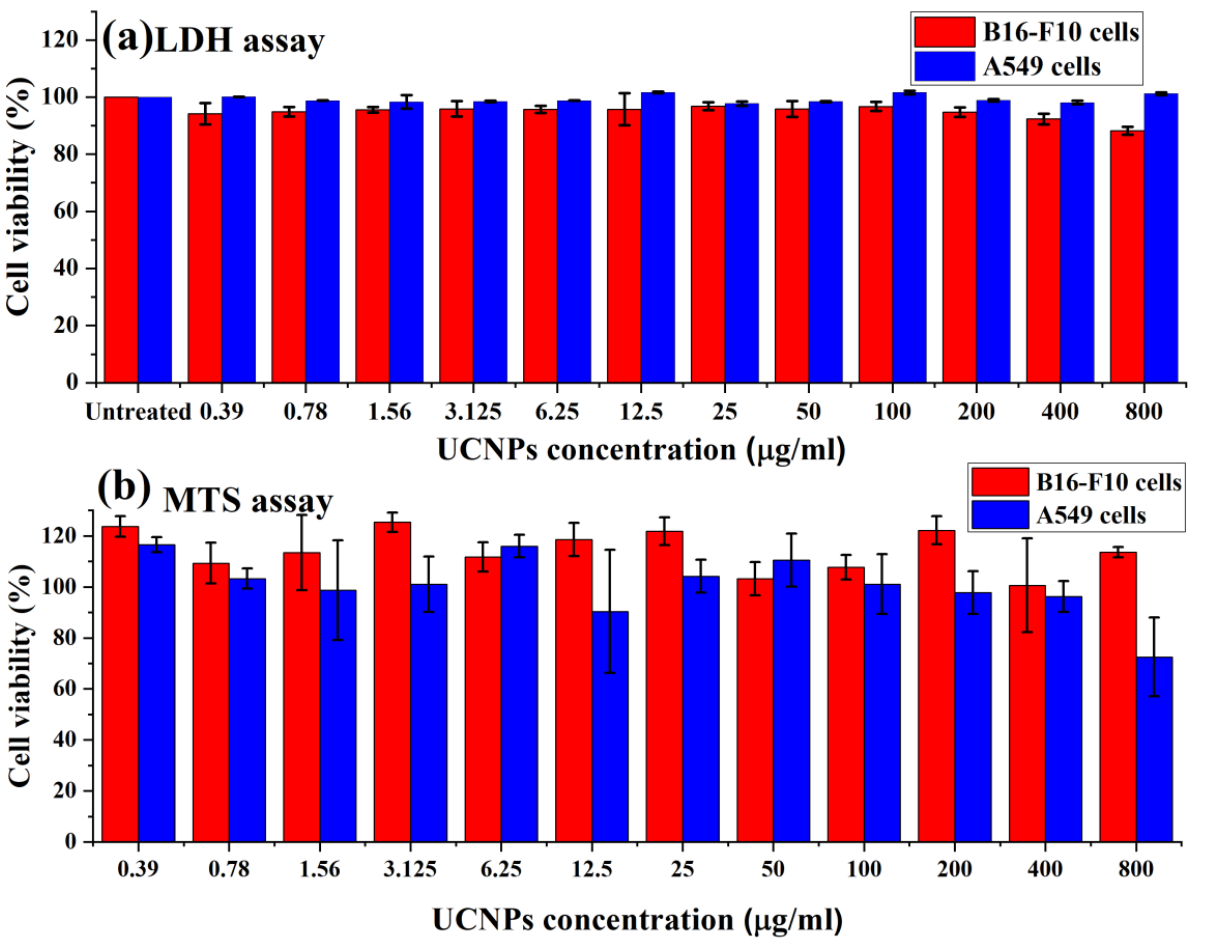
Figure 4. Cell viability of UCNPs after incubation with B16-F10 and A549 cells for 4 h. The data are the result of ( a ) LDH and ( b ) MTS assays, which are expressed as cell viability (%) and presented as the mean ± SD ( n =